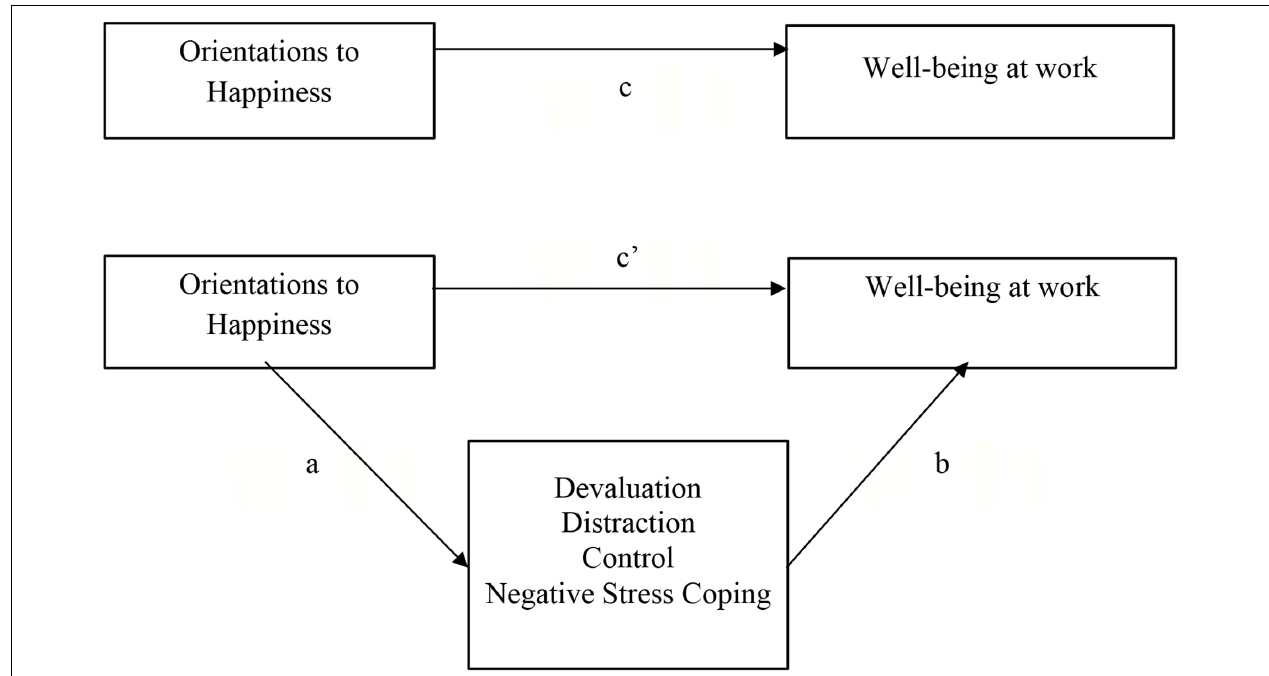
FIGURE 1 | Parallel mediational model. Total ( c ), direct ( c’ ) and indirect effects ( ab ) of the orientations to Happiness (Pleasure, Engagement, Meaning) on Well-being at work (work satisfaction, work stress) via the mediators Positive (Devaluation, Distraction, Control) and Negative Coping